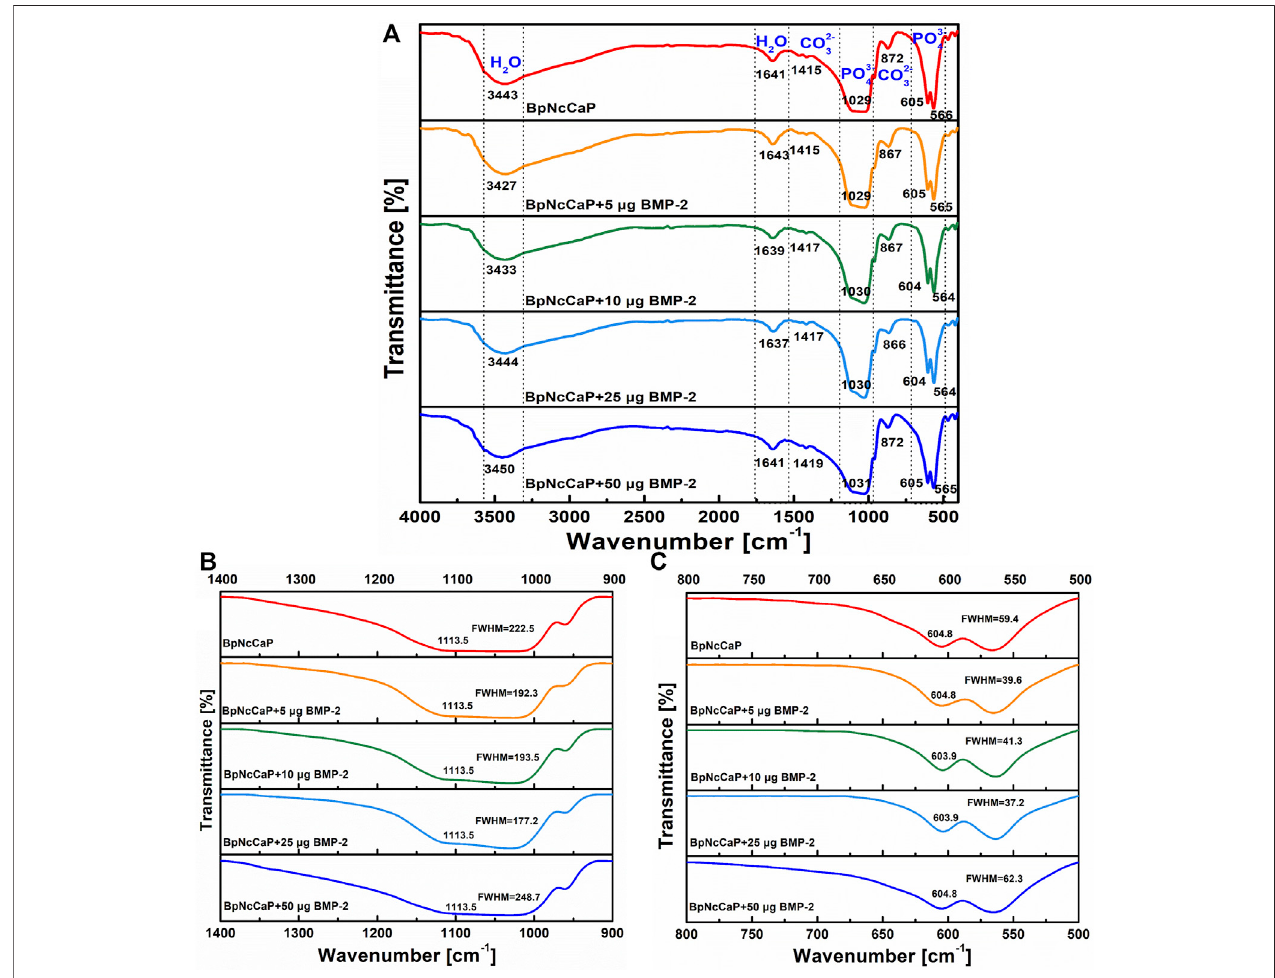
FIGURE 4 | Total FTIR spectra (A) , FTIR spectra focusing on ν 3 phosphate stretch in the 900 – 1,400 cm − 1 wavenumber range (B) , and FTIR spectra focusing on ν 4 bend in the 500 – 800 cm − 1 wavenumber range (C) for BpNcCaPs without or with different amounts (5/10/25/50 μ g) of BMP-2.